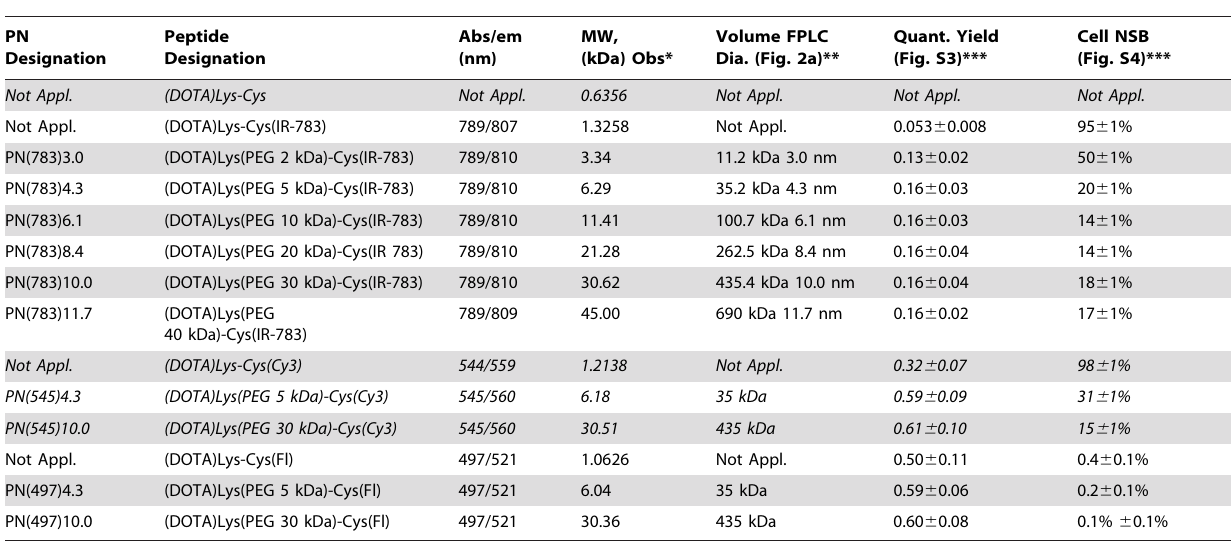
Table 1. Summary of PEG-like Nanoprobes